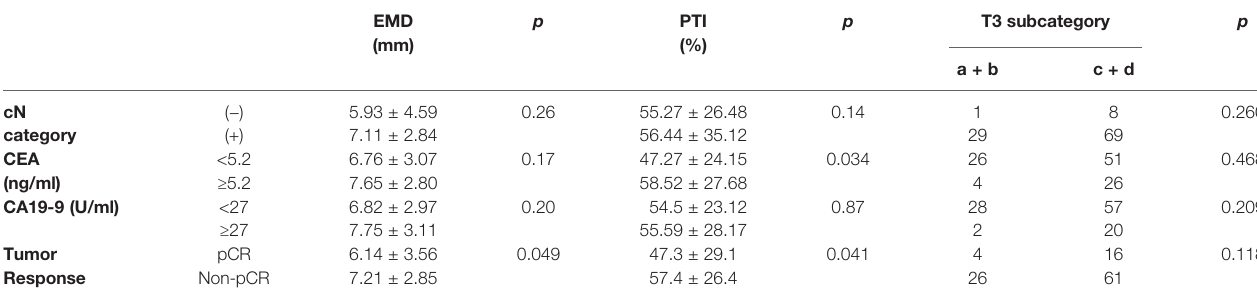
TABLE 2 | Difference of EMD, PTI and T3 subcategory according to the cN category, CEA, CA19-9 and pCR in T3 rectal cancer.